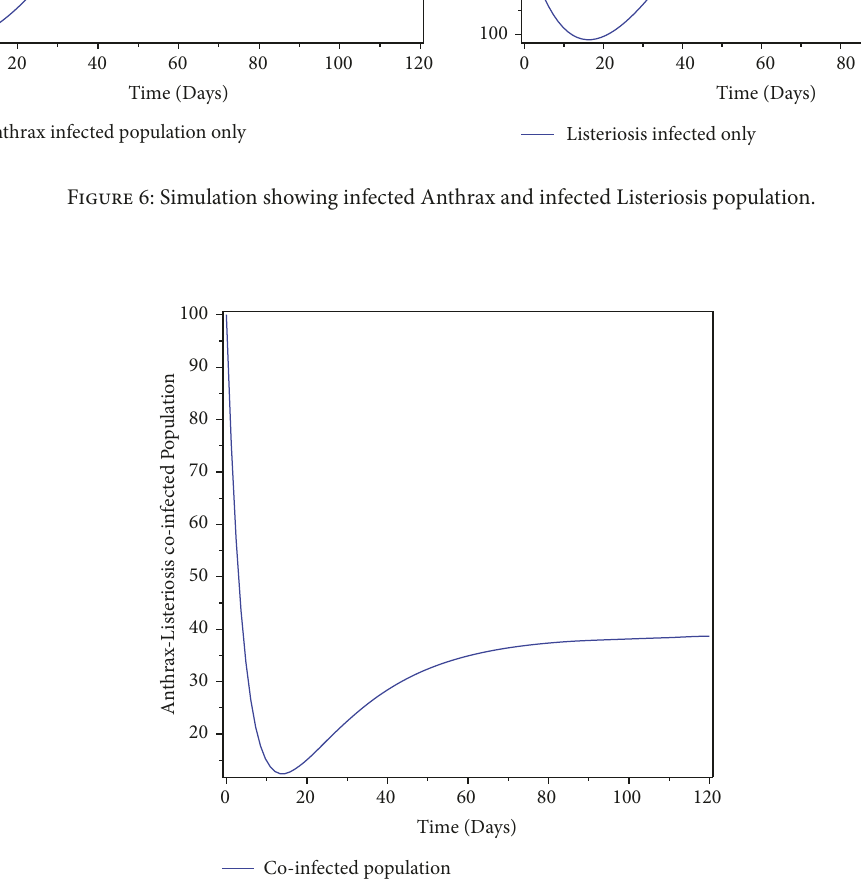
Figure 7: Simulation of model showing Anthrax-Listeriosis coinfection